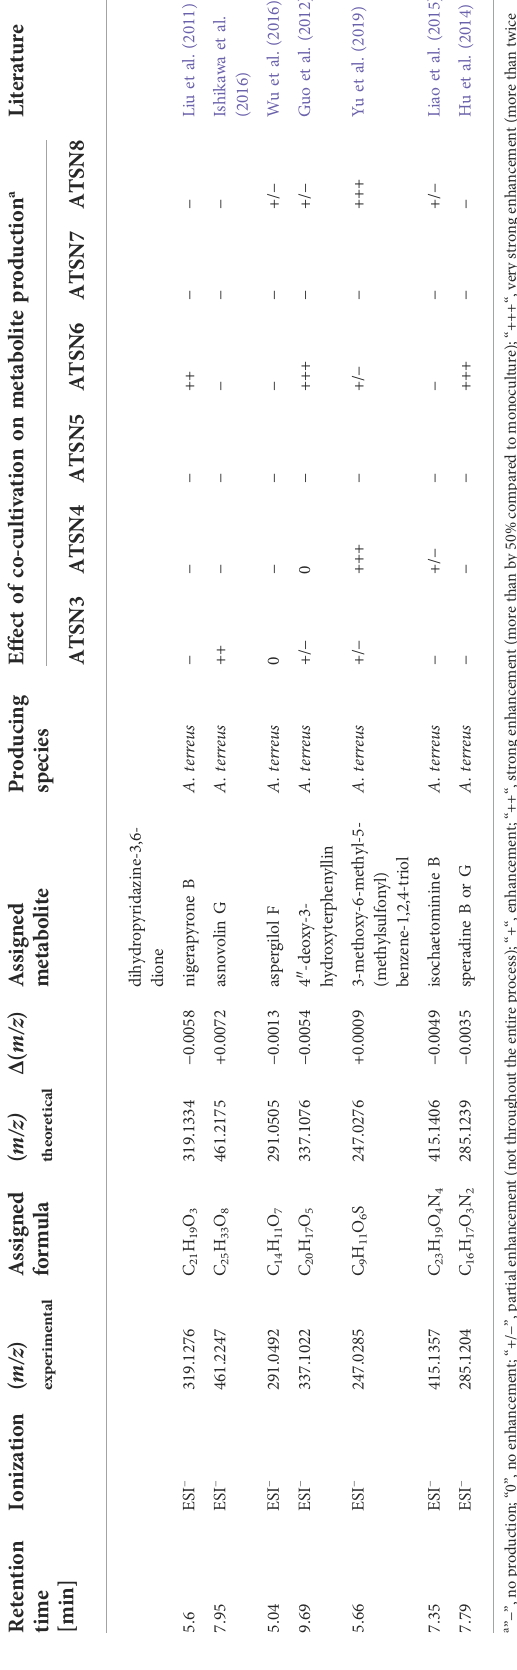
(Supplementary Figure S7), and obscurolide B3